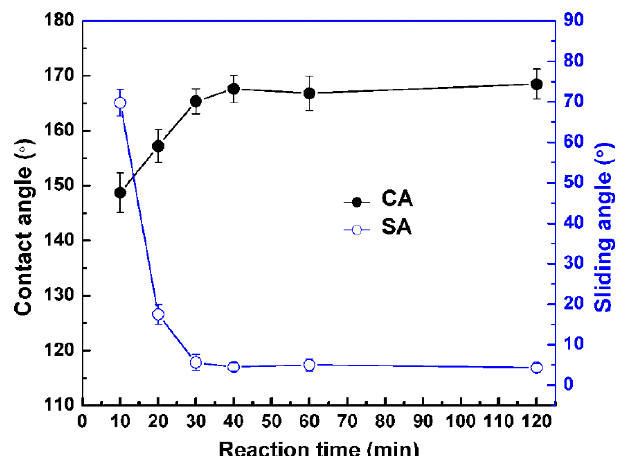
Figure 3. Water contact angles and sliding angles of the as-prepared Cu 2 O surface with di ff erent reaction times.